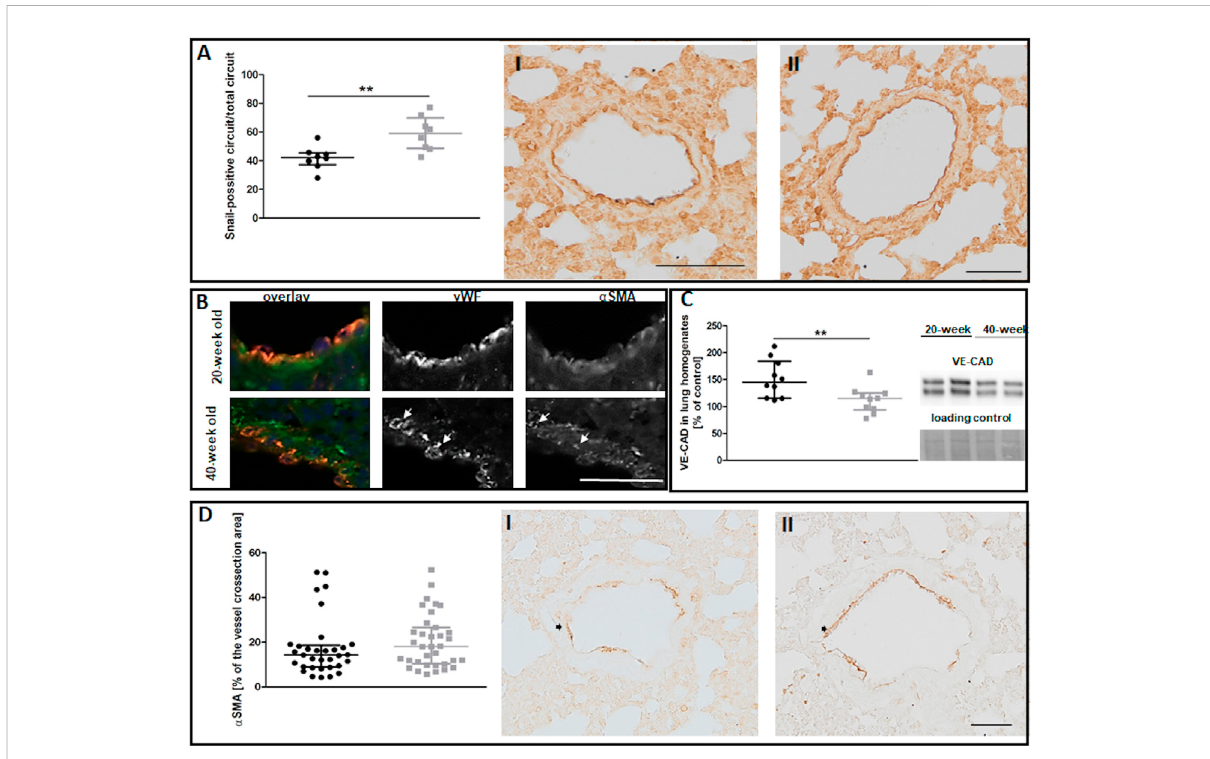
FIGURE 3 TheEndMTinthelungsofuntreated20-week-oldand40-week-oldBALB/cmice.Blacksymbolsdenote20-week-olduntreatedcontrolmice, and grey symbols denote untreated control 40-week-old mice. (A) The quantitative analysis of Snail levels in the endothelium of randomly chosen pulmonary vessels. Representative images at ×200 magni fi cation are shown for 20-week-old (I) and 40-week-old (II) mice ( n = 8). (B) Co- occurrence of vWF and α SMA in lung vascular endothelial cells in untreated control 40-week-old and 20-week-old BALB/c mice is shown at ×400 magni fi cation and indicated by white arrows. (C) Quanti fi cation of VE-CAD protein levels in lung homogenates of untreated control 20- week-old and 40-week-old mice shown by representative western blots ( n = 10). (D) Quantitative analysis of α SMA levels in randomly chosen pulmonary vessels ( n = 33 – 35). Representative images at ×200 magni fi cation are shown for 20-week-old (I) and 40-week-old (II) mice with the analysed vessels indicated by black arrows. The scale bar in (A) represents 100 μ m, in (B) 50 μ m, in (D) 50 μ m. All data in (A) and (C) were compared with parametric unpaired Student ’ s t -test. All data in (D) were compared with non-parametric Mann-Whitney U test. The results are shown as the median and IQR. Key: ** p <